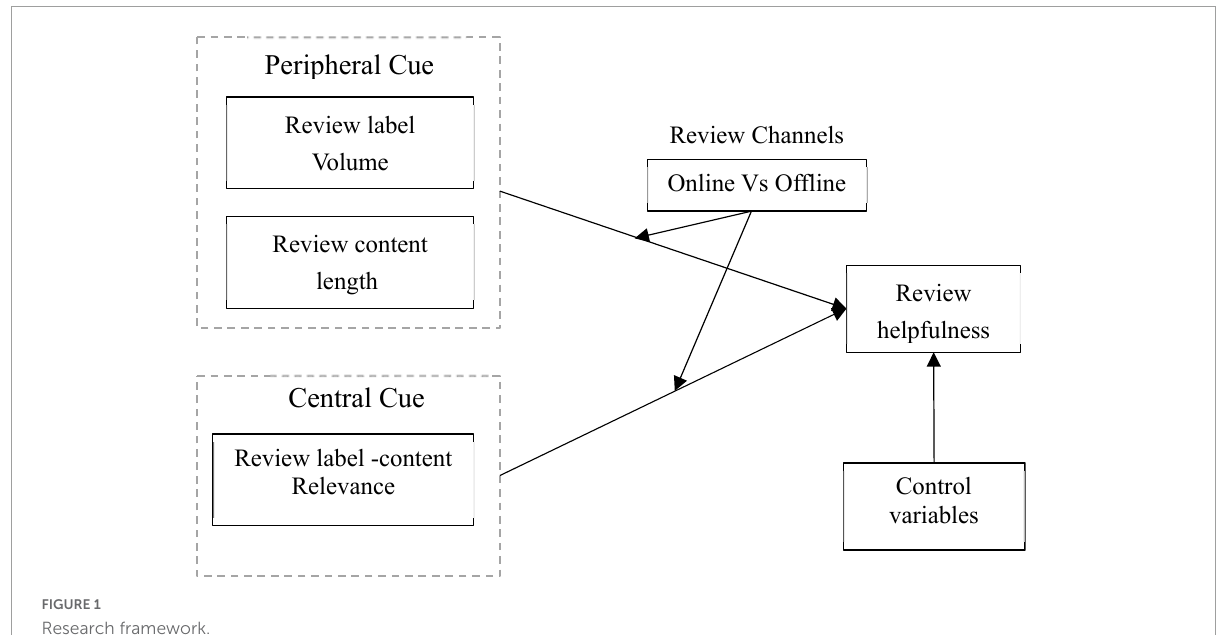
FIGURE1 Research